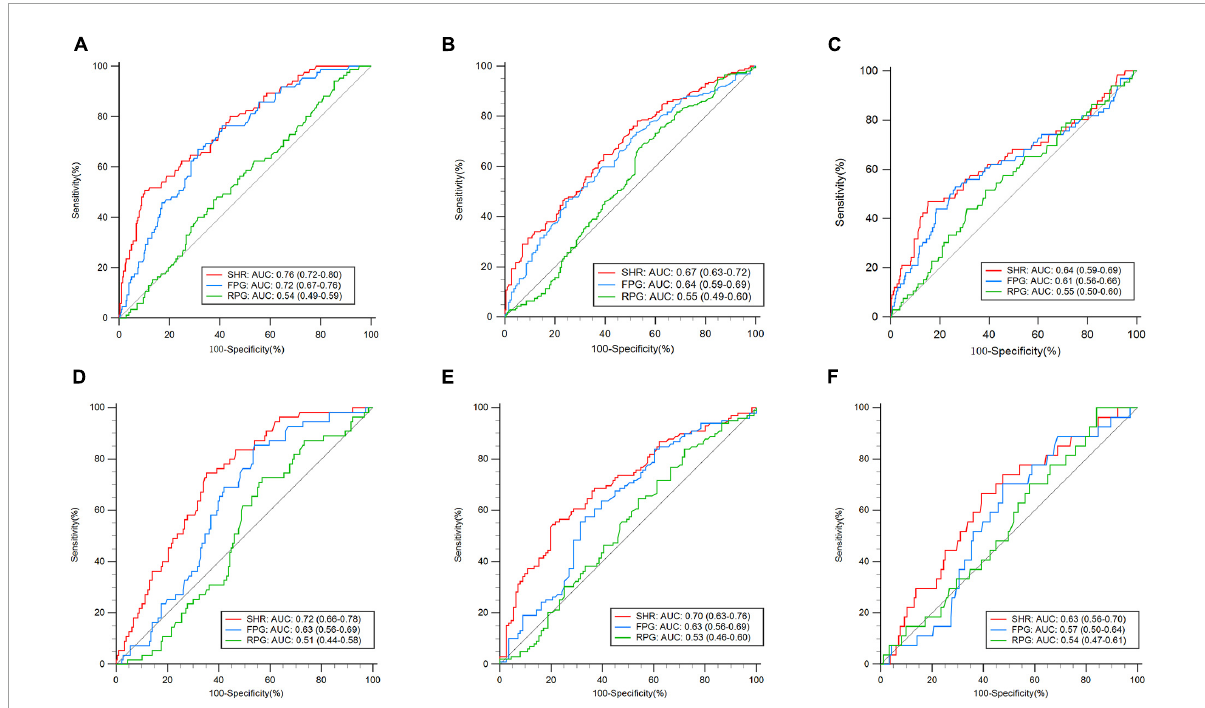
FIGURE2 Receiver operating characteristic curve (ROC) analyses of the stress hyperglycemia ratio (SHR), admission fasting plasma glucose (FPG), and admission random plasma glucose (RPG) for the prediction of outcomes. Training dataset: (A) moderate-to-severe cerebral edema (CED), (B) 90-day poor functional outcome, and (C) 90-day death. Validation dataset: (D) moderate-to-severe CED, (E) 90-day poor functional outcome, and (F) 90-day